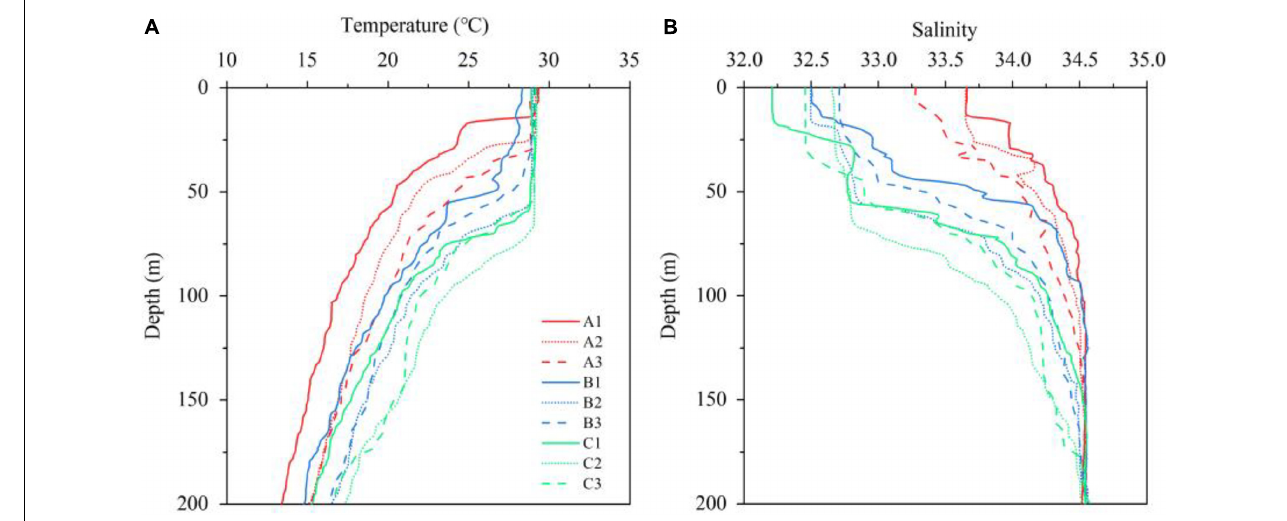
FIGURE 2 | Vertical profiles of temperature (A) and salinity (B) above 200 m at each station.